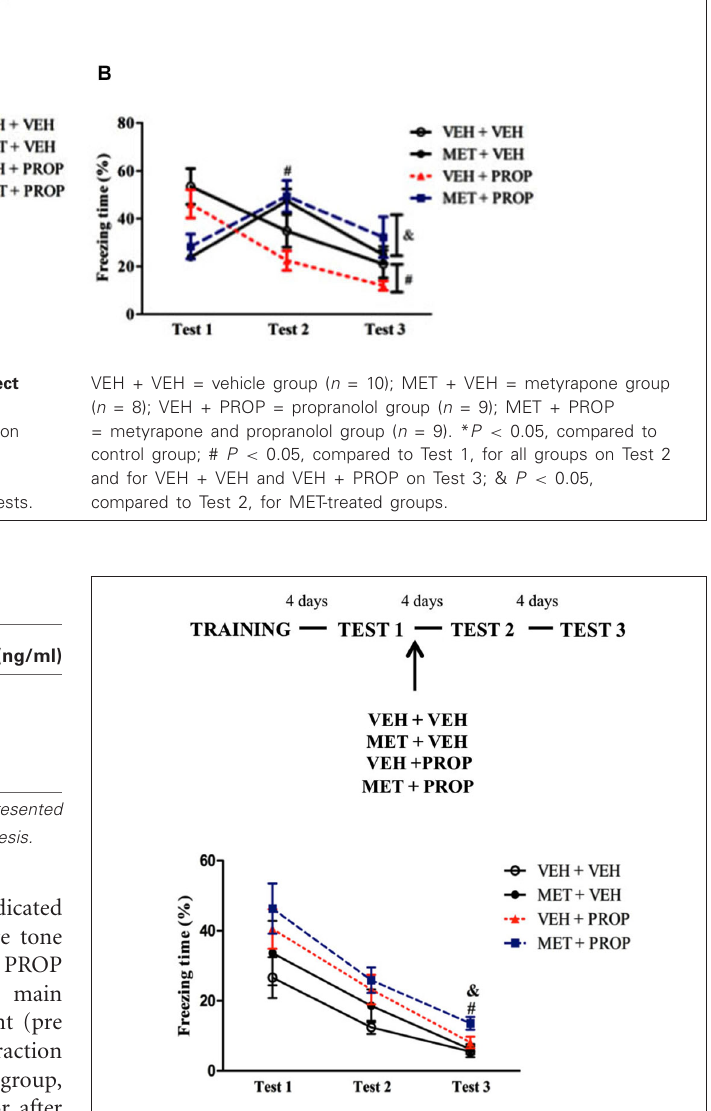
FIGURE 5 | Acute metyrapone and propranolol treatments immediately after contextual fear memory reactivation did not modify fear memory expression . There were no differences between the groups when the treatments were administered immediately after Test 1. VEH + VEH = vehicle group ( n = 8); MET + VEH = metyrapone group ( n = 7); VEH + PROP = propranolol group ( n = 10); MET + PROP = metyrapone and propranolol group ( n = 9). &# P < 0.05, compared to Test 1, for all groups; & P < 0.05, compared to Test 2, for all groups.